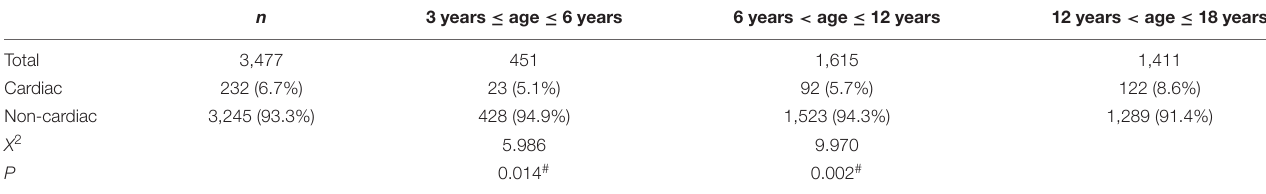
TABLE 2 | The cause of chest pain in children with different